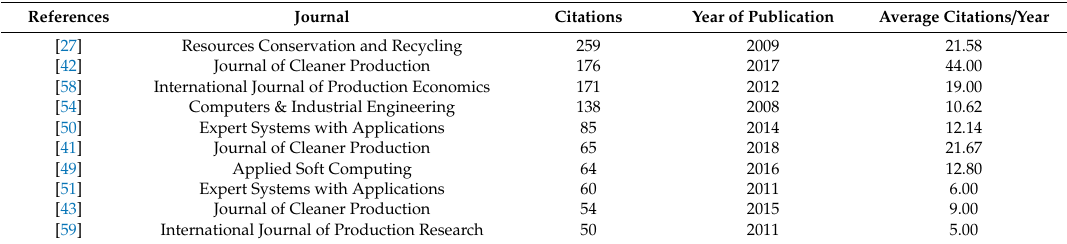
Table 4. Most cited articles.